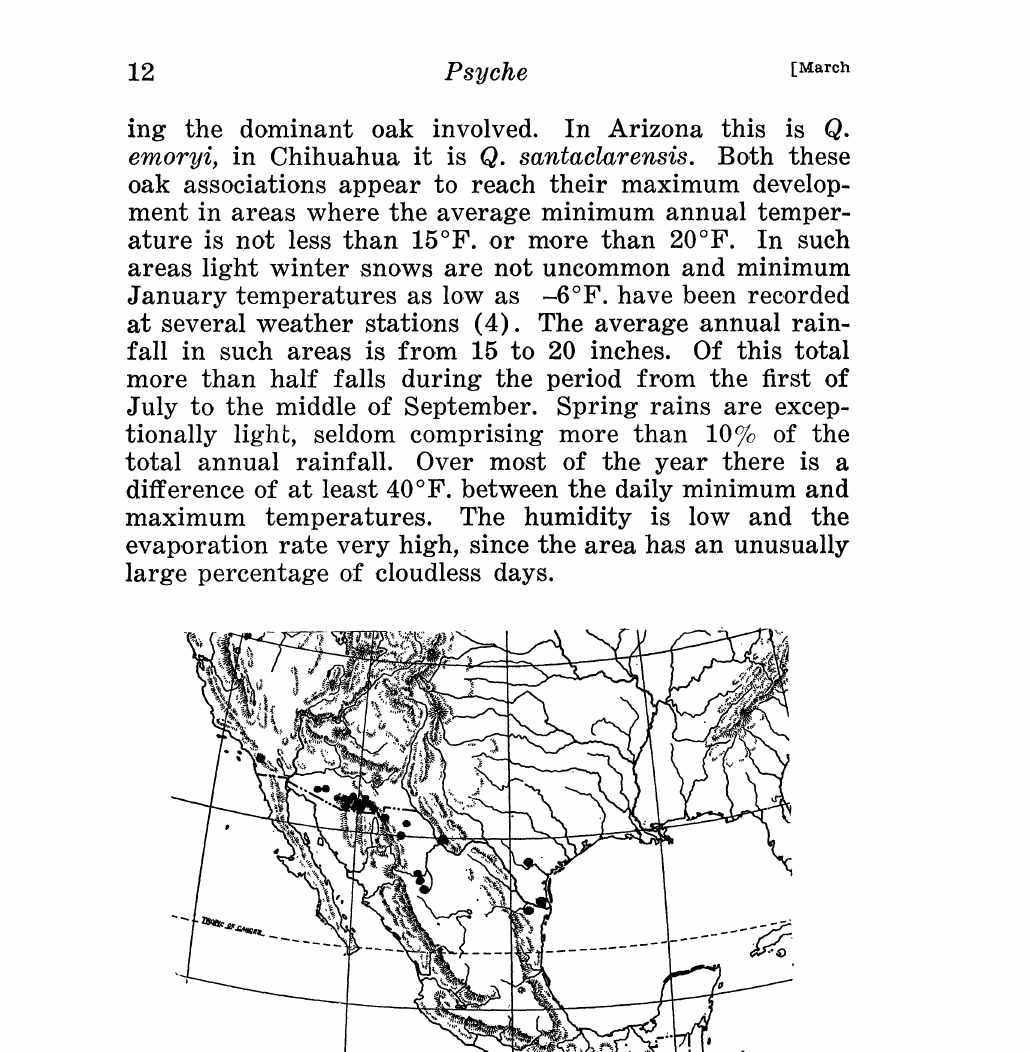
Fig. 1. Map showing the known distribution of Pseudomyrmex apach in the southwestern United States and northern